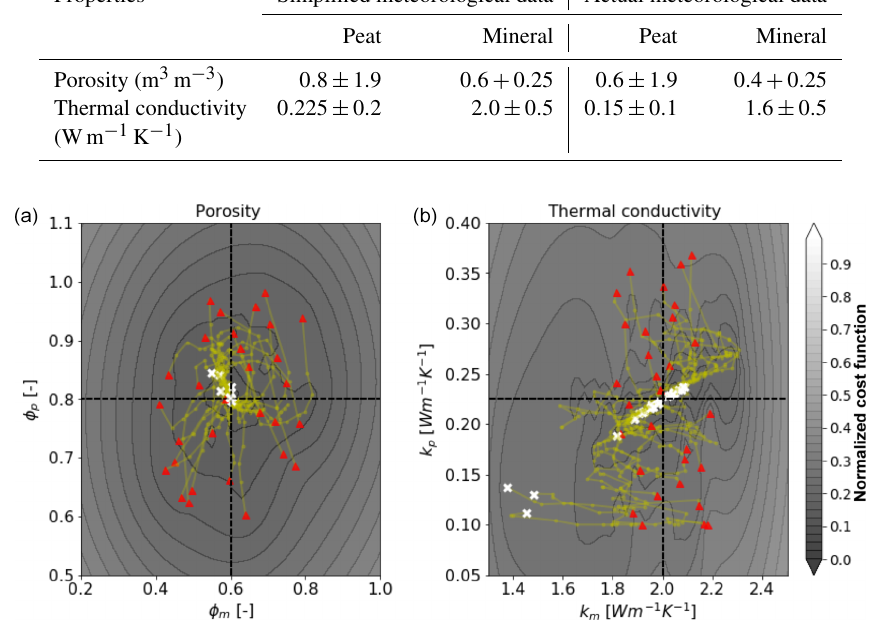
Figure 4. Estimated properties from 30 inversions of the (S)3T3s l 1 ρ a case, where the “true” values are shown as a cross section of two dashed lines for the bulk porosities and effective thermal conductivities for peat and mineral soil layers. Yellow lines correspond to the paths taken by the LM algorithm. The white dots correspond to the estimated values. (a) Projection of the cost function with respect to porosities of the peat and mineral layer. (b) Projection of the cost function with respect to thermal conductivities of the peat and mineral layer. The color bar represents the cost function normalized by its maximum logarithmic value.